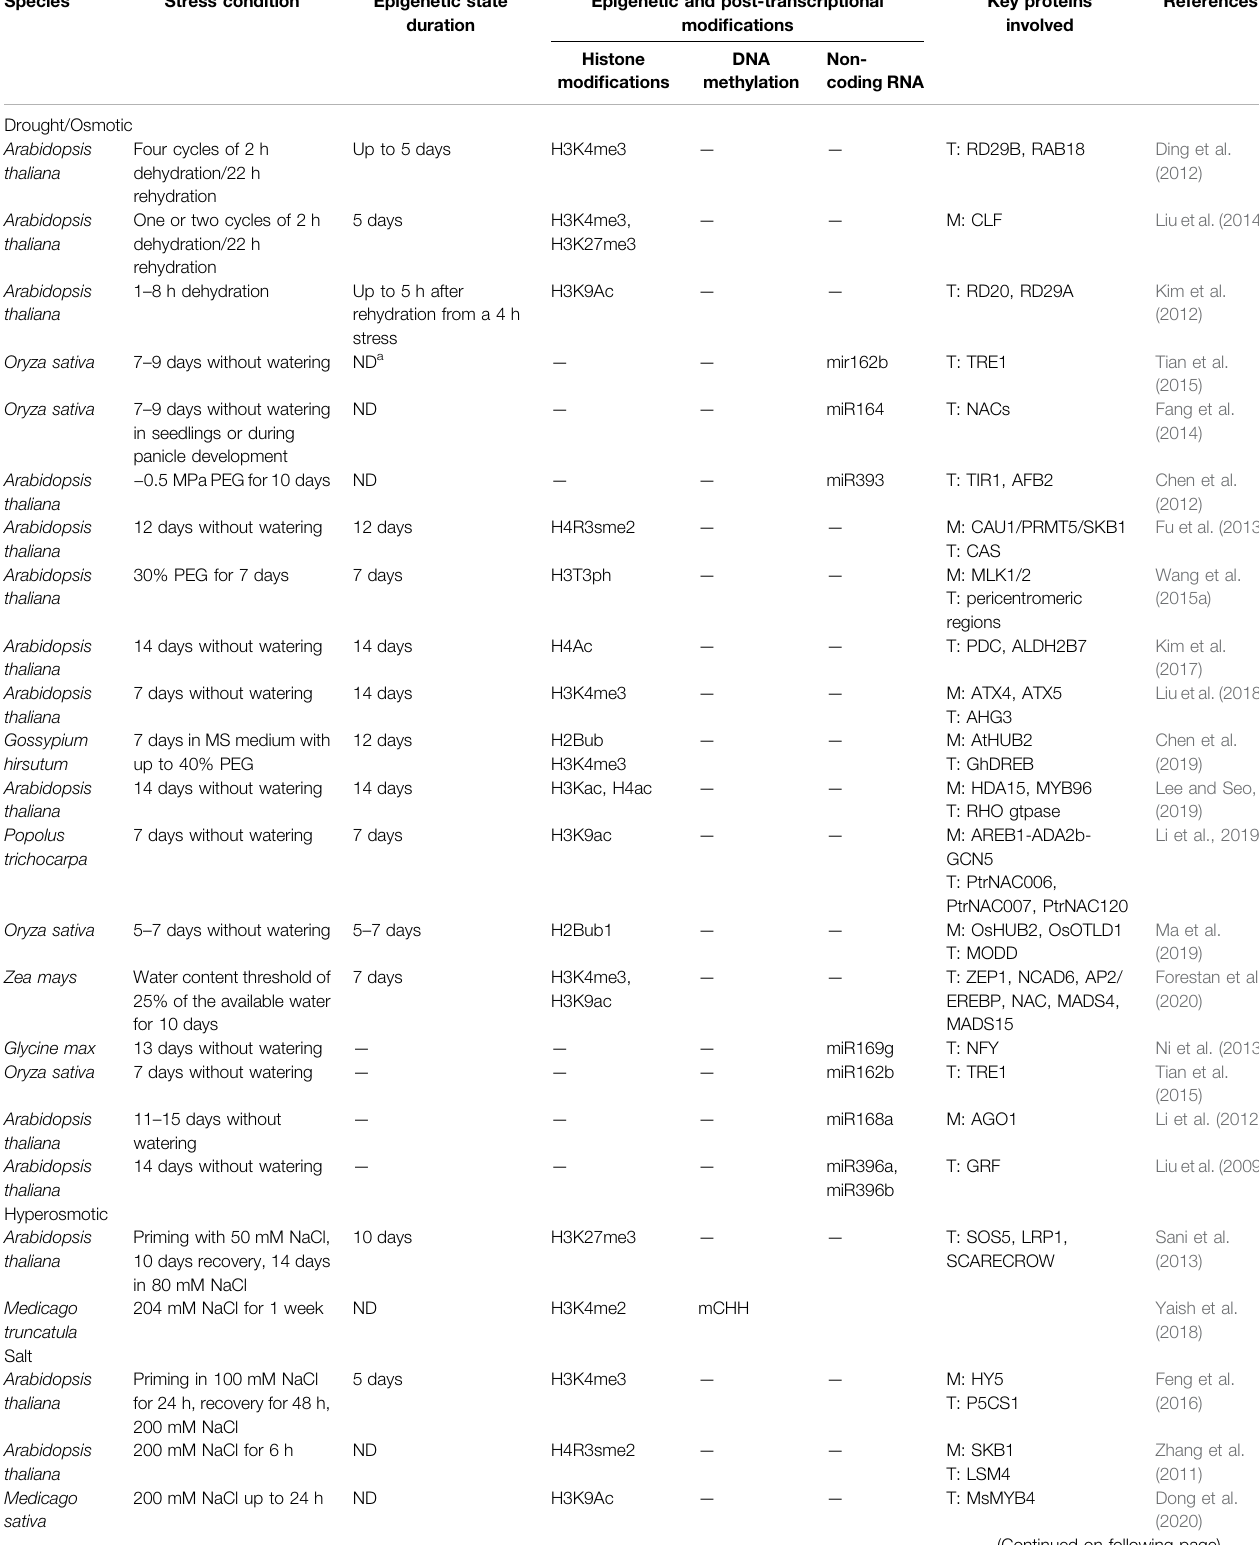
TABLE 1 | Most recent examples of epigenetic modi fi cations in plants in response to different types of abiotic stresses. Duration of epigenetic state, type of epigenetic modi fi cation, key proteins involved (M: mediators; T: their targets).